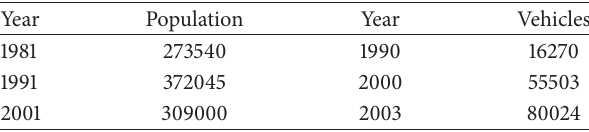
Figure 2: Flow chart of methodology for land use/land cover and change detection. Table 1: Study area population and vehicle fleet ∗